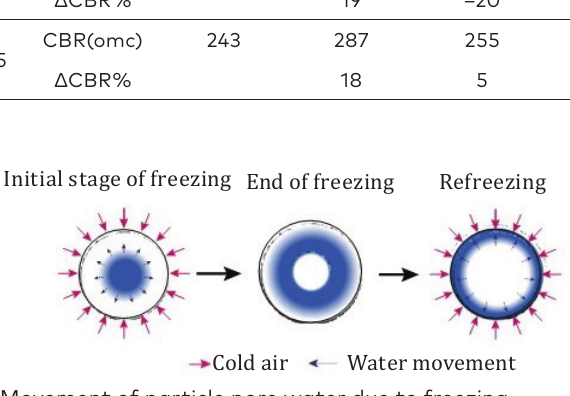
Figure 12. Movement of particle pore water due to